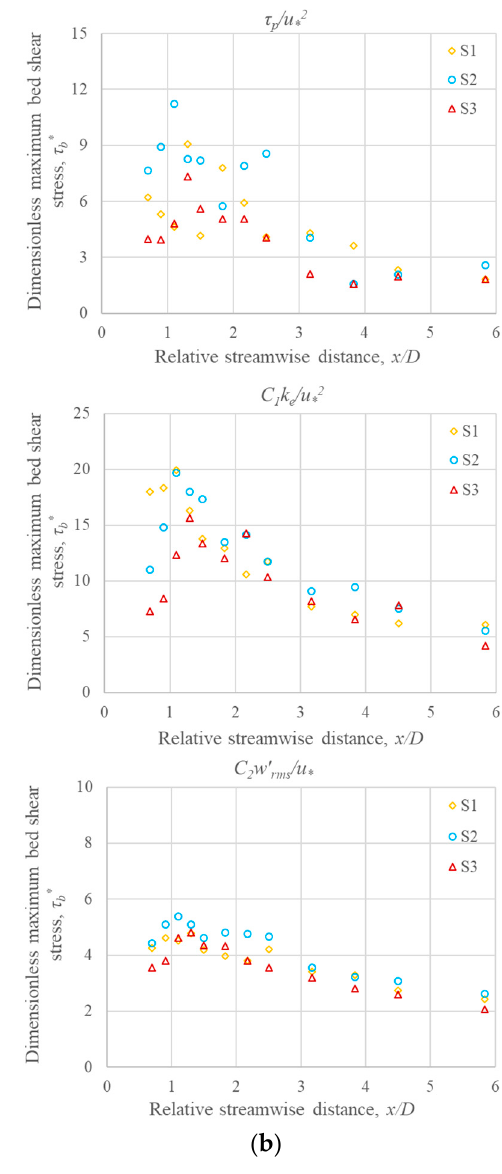
Figure 9. Variation of dimensionless maximum near-bed shear stress ( 𝜏 (cid:3029)∗ ) using the Reynolds (Equation (3)), TKE (Equation (4)), and modified TKE (Equation (5)) methods in the symmetry plane: ( a ) midstream and ( b ) downstream.